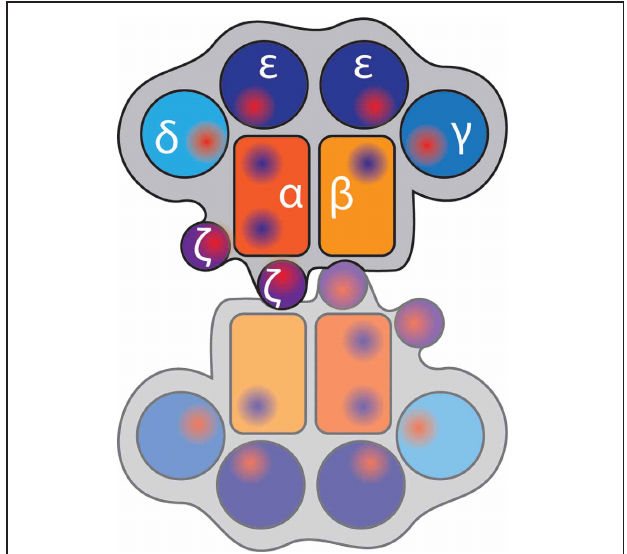
FIGURE 4 | Model of TCR complex dimerization. Heterodimers of TCR α and TCR β (orange and yellow) are opposed due to the short ectodomains of CD3 ζ (purple), which places CD3 γ , CD3 δ , and the two CD3 ε chains (shades of blue) around the outside. The shapes represent immunoglobulin domains of the components; and red and blue shaded regions indicate positive and negatively charged regions,